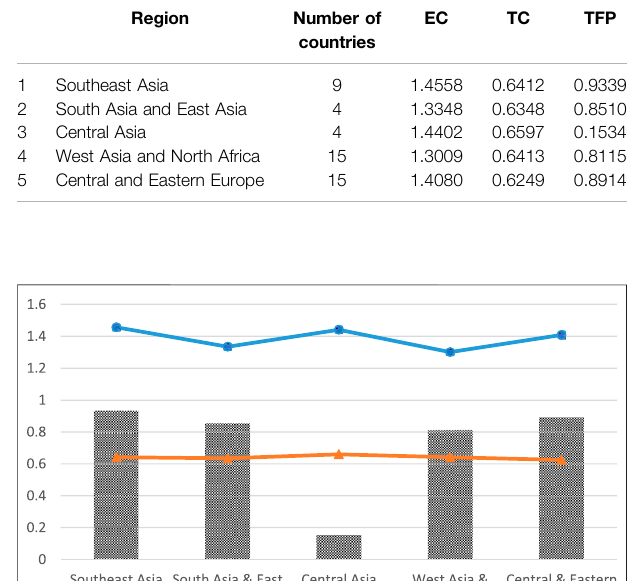
TABLE 7 | Average productivity growth. TABLE 8 | Average regional productivity changes (2010 – 2018).